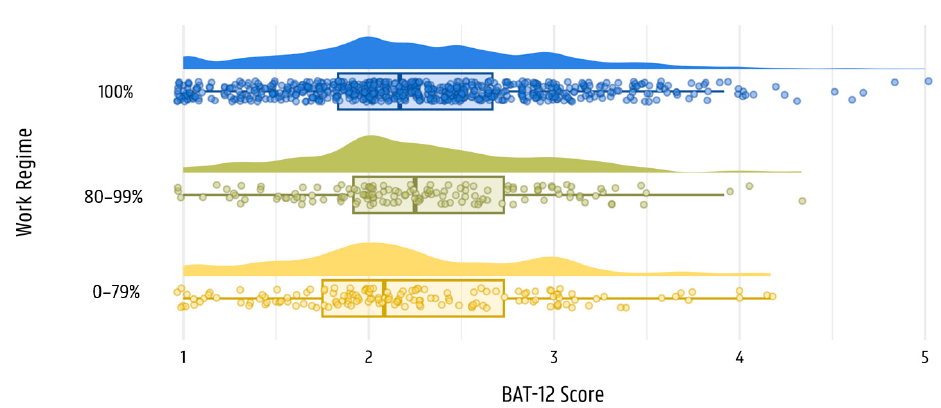
Figure A1. Raincloud plot for work regime and overall burnout risk according to work regime.